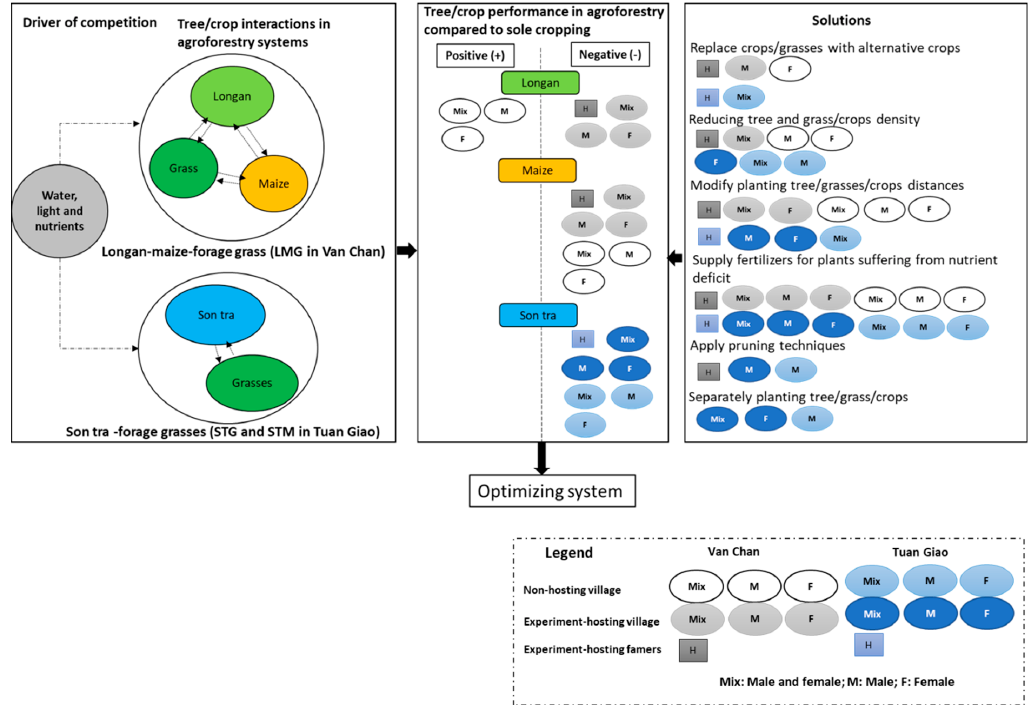
Figure 7. Farmers’ perception of the performance of trees and crops in the agroforestry experiments in Van Chan and Tuan Giao compared with that of sole crops / trees. Open-ended questions were used in group interviews with non-hosting and experiment-hosting villages; experiment-hosting farmers were interviewed